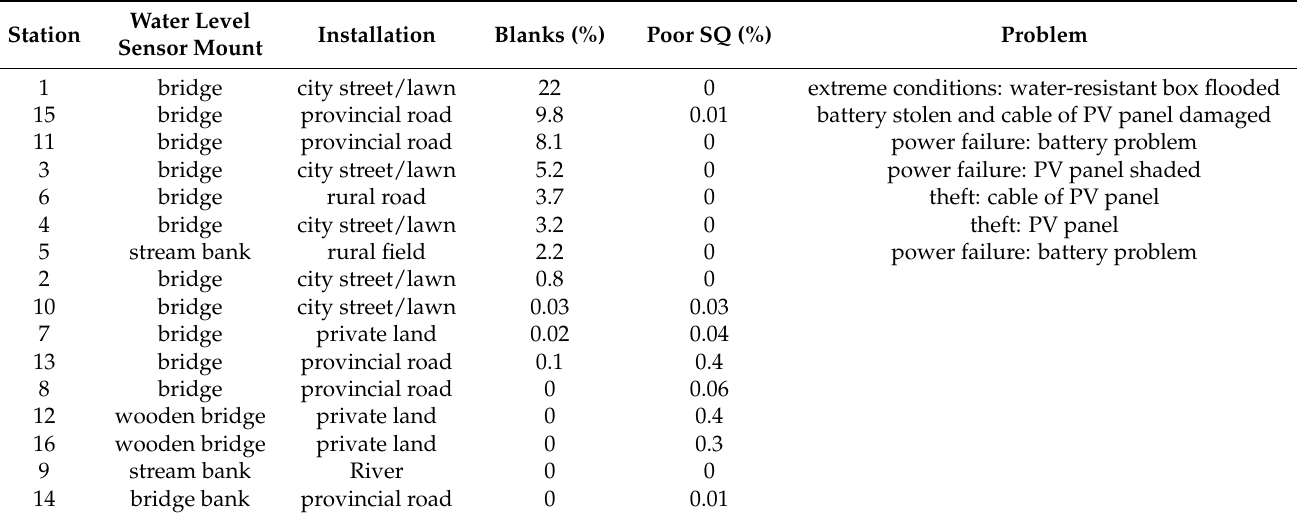
Table 3. Frequency of common problems and errors after data quality control checks of all stations for the time period 2020 and 2021: missing data (blanks) and poor signal quality